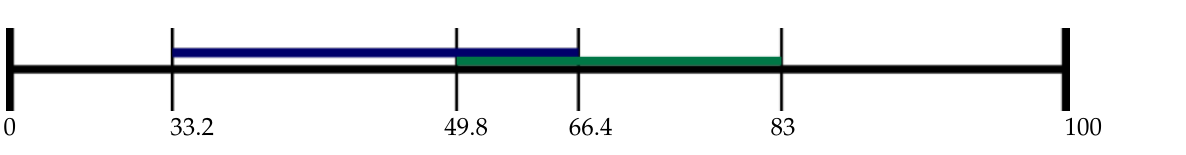
Figure 6. The unions and intersections of the supplier